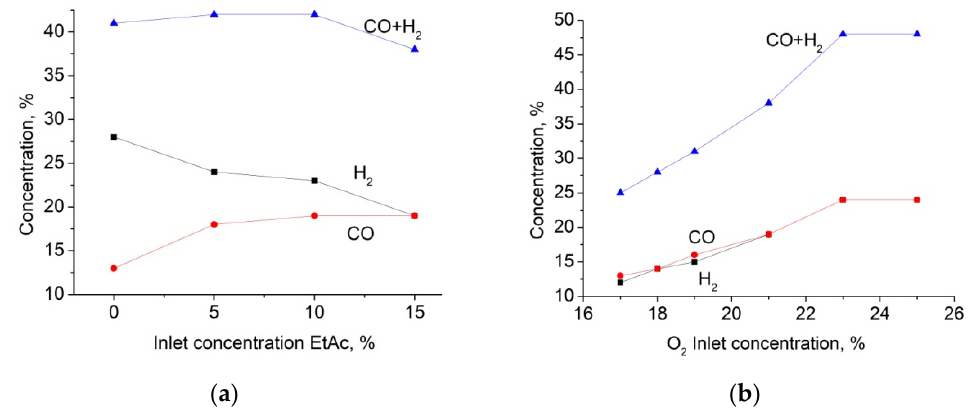
Figure 11. Dependence of products concentration on ethyl acetate ( a ) or O 2 ( b ) content in the autothermal reforming of the mixture of natural gas and ethyl acetate in radial reactor with the heat exchanger and LaNi(Pt)O 3 /La 0.1 Ce 0.45 Zr 0.45 O 2 active component. Feed 20% NG +18 % O 2 +N 2 +EtAc ( a ) or 10% NG + O 2 + N 2 + 15% EtAc ( b ), flow rate 2.5 m 3 /h.